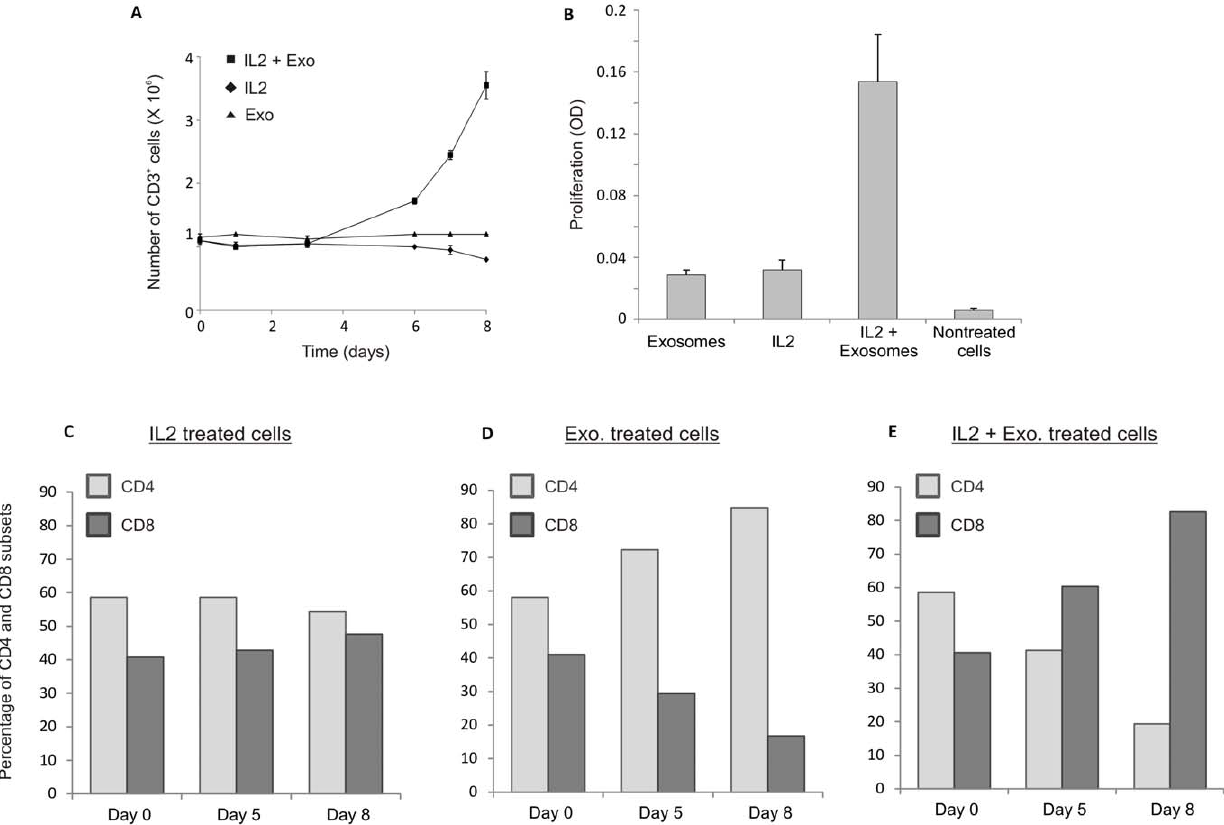
Figure 2. Proliferation of CD3 + T cells pulsed with autologous exosomes. (A) Number of CD3 + T cells measured with automatic cell counting (Sysmex) at different time points. Cells stimulated with IL-2 + exosomes are increasing in numbers. (B) Proliferation of CD3 + T cells measured with MTT assay at day five. Cells stimulated with IL-2 + exosomes showed increased proliferation. (C) Distribution of CD4 + and CD8 + cells in CD3 + T cells stimulated with IL-2, autologous exosomes or IL-2 + exosomes measures with flow cytometry.